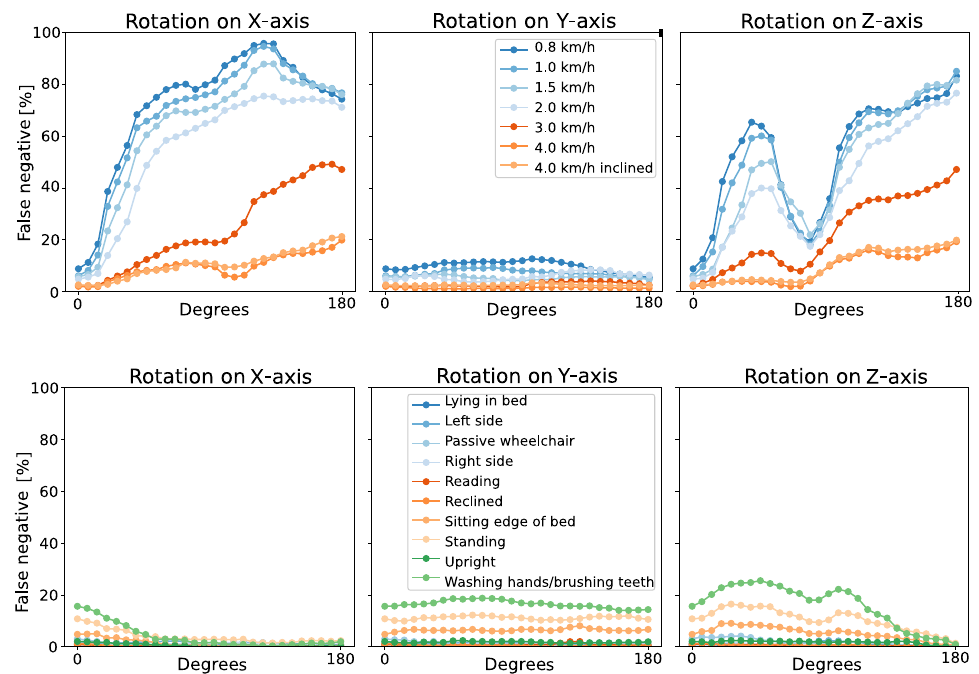
Figure 5. Top panels show false negative percentage profiles of treadmill walking activities; bottom panels report false negative percentage profiles of static activities. Rotations on the X-, Y-, and Z-axis correspond to rotations applied along the frontal, longitudinal, and sagittal axis, respectively.